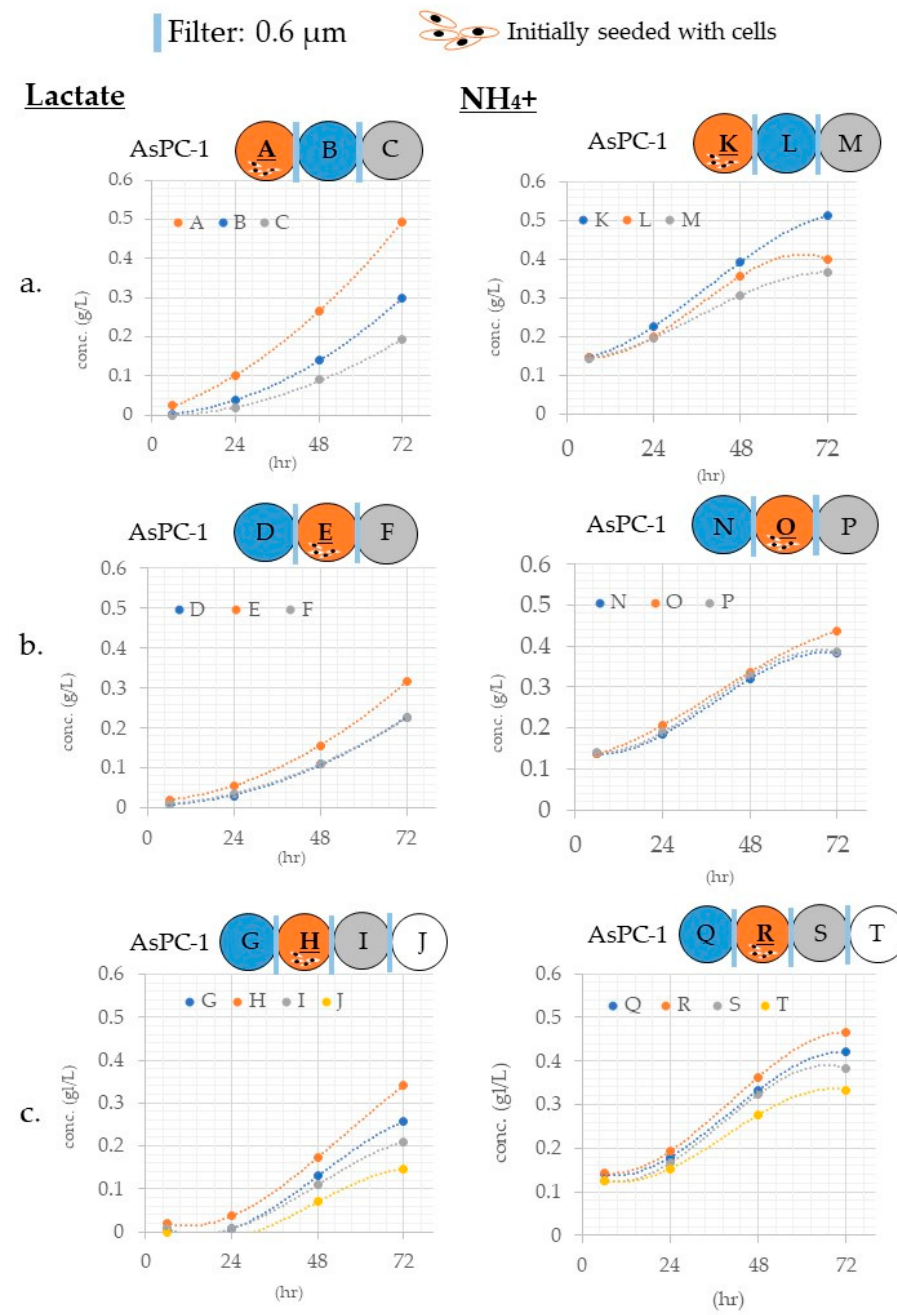
Figure 5. The same number of cells were placed in wells with clip art of the cell. Lactate and NH 4+ concentration in the medium were measured regularly for 24–72 h. The vertical axis is the concentration, and the horizontal axis is the elapsed time. The results of the three or four connected plates are shown. Lactic acid measurement results on the left, NH 4+ measurement results on the right. The polynomial approximation showed the best correlation. Correlation approximation equations and correlation coefficients are shown in Supplemental Tables S1–S3. ( a ) In case of 3 linkages and cells on the left side. ( b ) In case of 3 linkages and cells on the middle. ( c ) In case of 4 linkages and cells on the second from the left side.